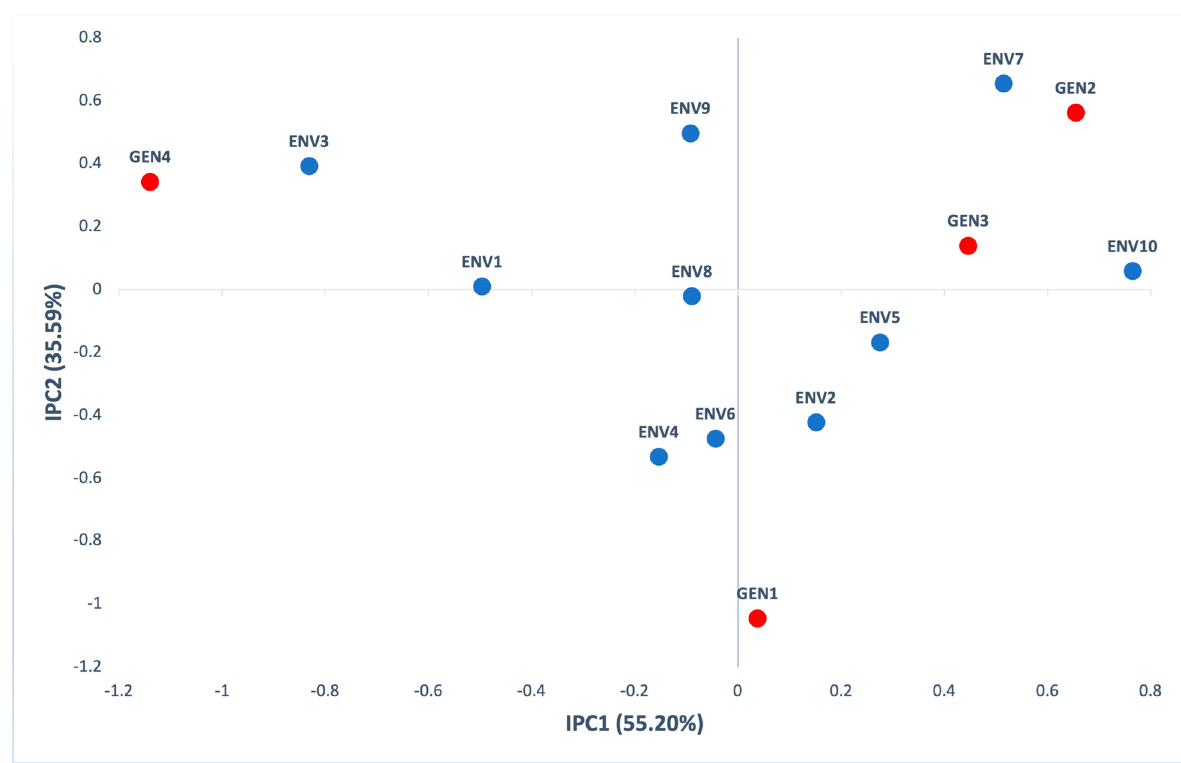
Figure 7. AMMI biplot presenting the second interaction principal components axis (IPC2) against the first interaction principal components axis (IPC1) scores for fiber content of 4 genotypes (red) evaluated in 10 environments (blue).